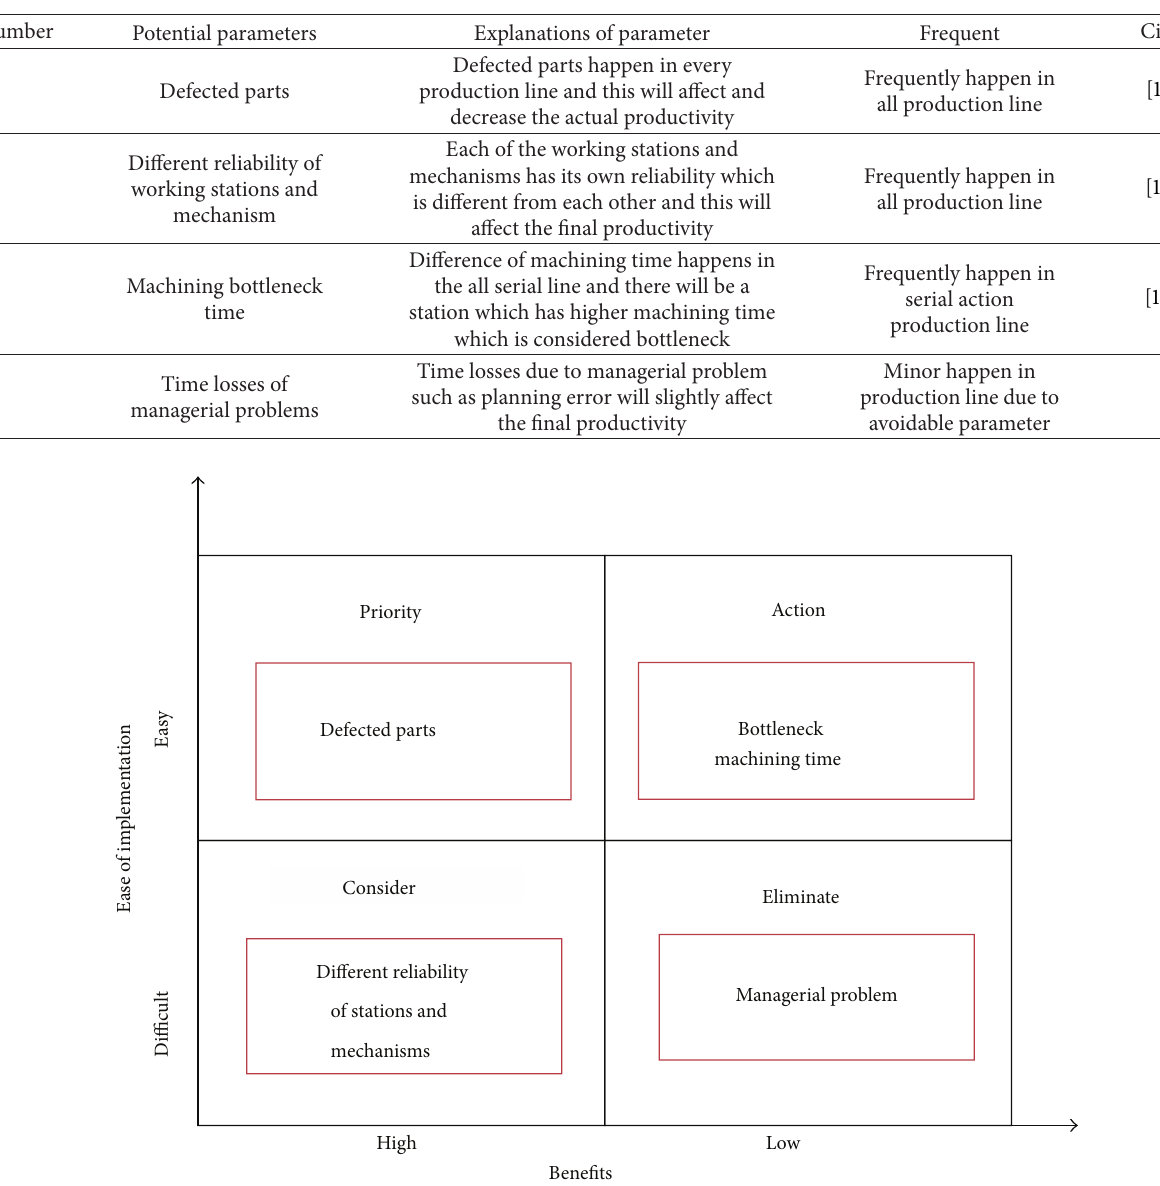
Table 5: Summary of potential parameters to enhance current productivity model.